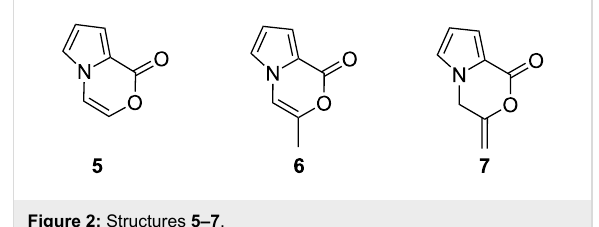
Figure 2: Structures 5–7